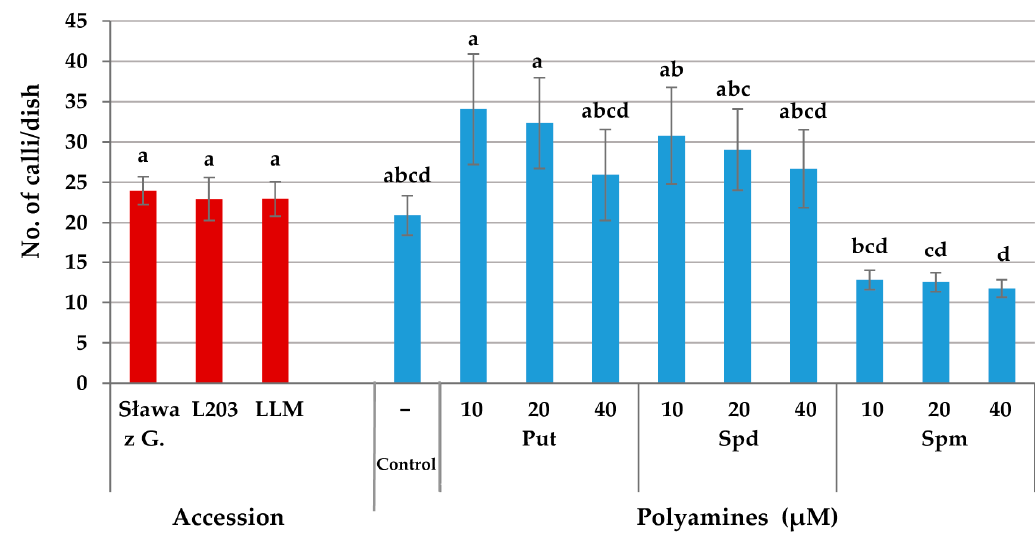
Figure 7. Effect of the accession and exogenous putrescine (Put), spermidine (Spd), and spermine (Spm) on the callus production from the protoplast-derived cells of Brassica oleracea L. var. capitata. The bars represent means ± SE ( n = 20). The red and blue bars should be considered separately. Values followed by the same letter were not significantly different ( p ≤ 0.05, HSD).